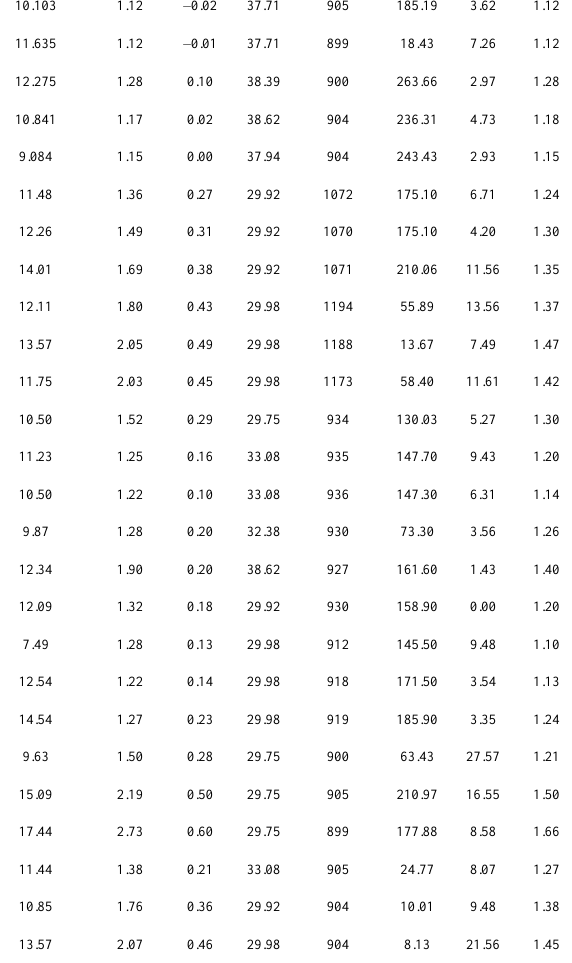
Table 5. Kastanozems soil’s measurement in Bornuur soum, 18~20 Sept. 2011